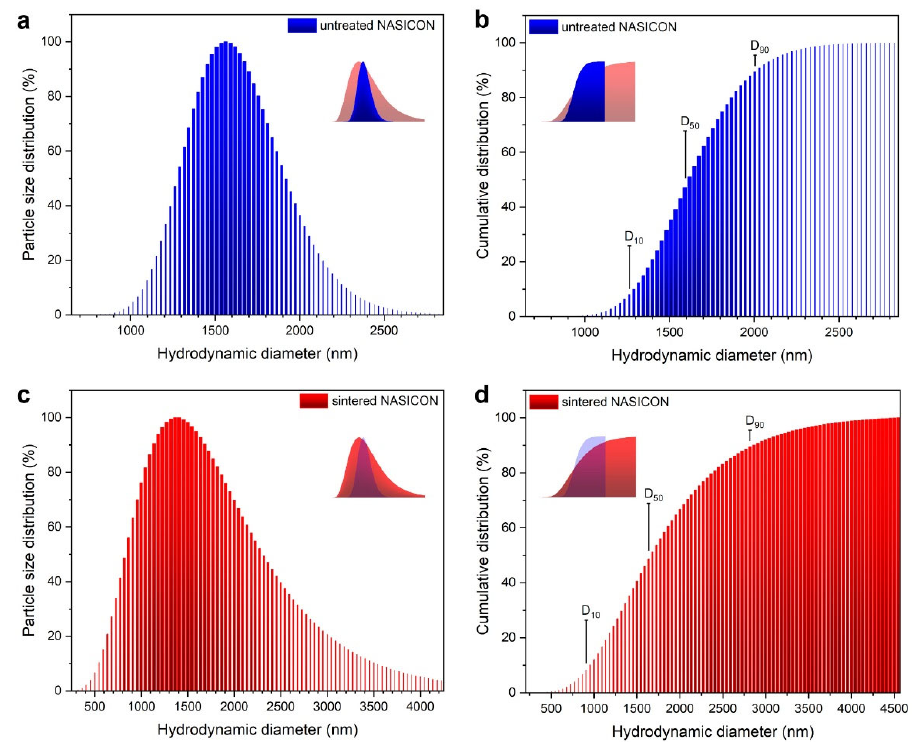
Figure 1. DLS analysis results of the particle size (and cumulative) distributions for NASICON powders ( a , b ) before; and ( c , d ) after thermal processing. Bar densities in histograms correspond to numerical frequency statistics; insets display graphical (areal) comparisons of distributions. Table 1. Statistical metrics of particle size distributions obtained by DLS of ball-milled powders, before and after sintering. Processing D mode Stage [nm]